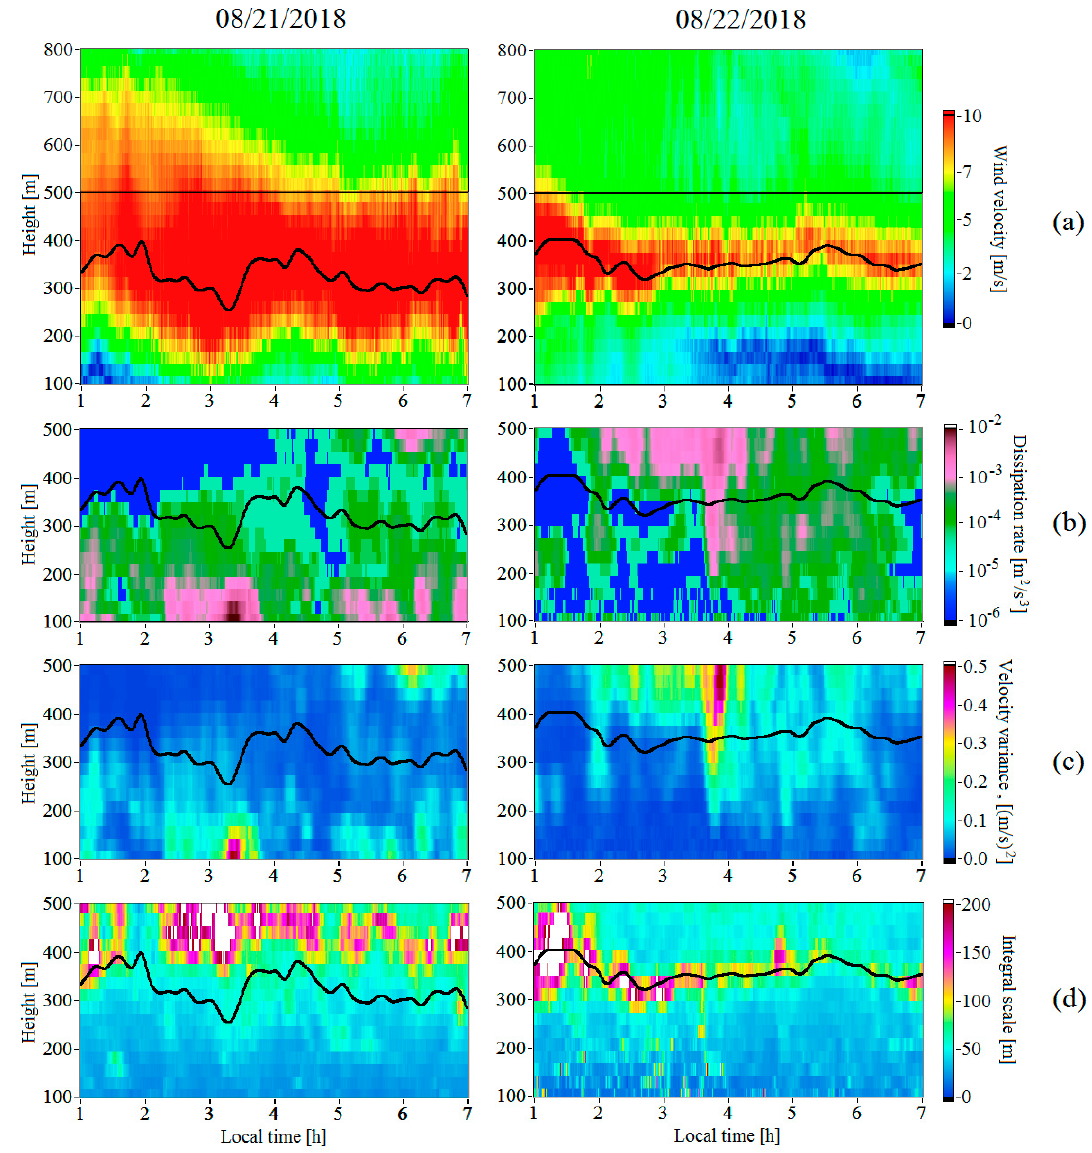
Figure 7. Height–temporal distributions of wind velocity ( a ), turbulent energy dissipation rate ( b ), variance of radial velocity ( c ), and integral scale of turbulence ( d ) assessed from the lidar data obtained during low-level jets (LLJs) on 21 (left) and 22 (right) August 2018. Black curves show the smoothed time series of the maximal wind velocity (LLJ center).